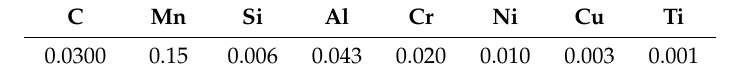
Table 1. Chemical composition of extra low carbon steel in weight percentage (wt %).